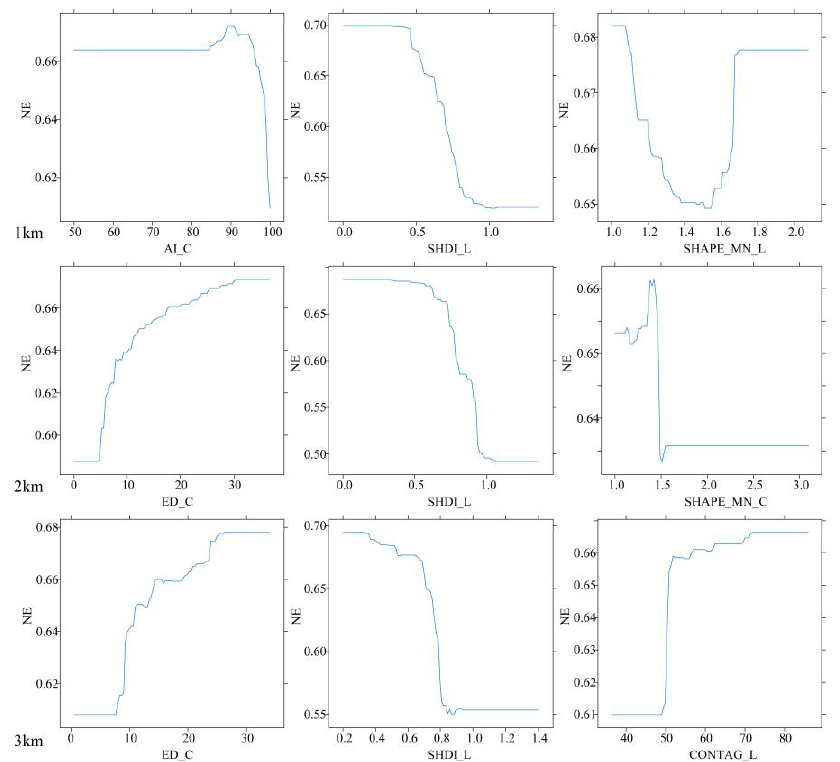
Figure 7. The partial dependence plots of NE on the three most important landscape metrics at different spatial scales.